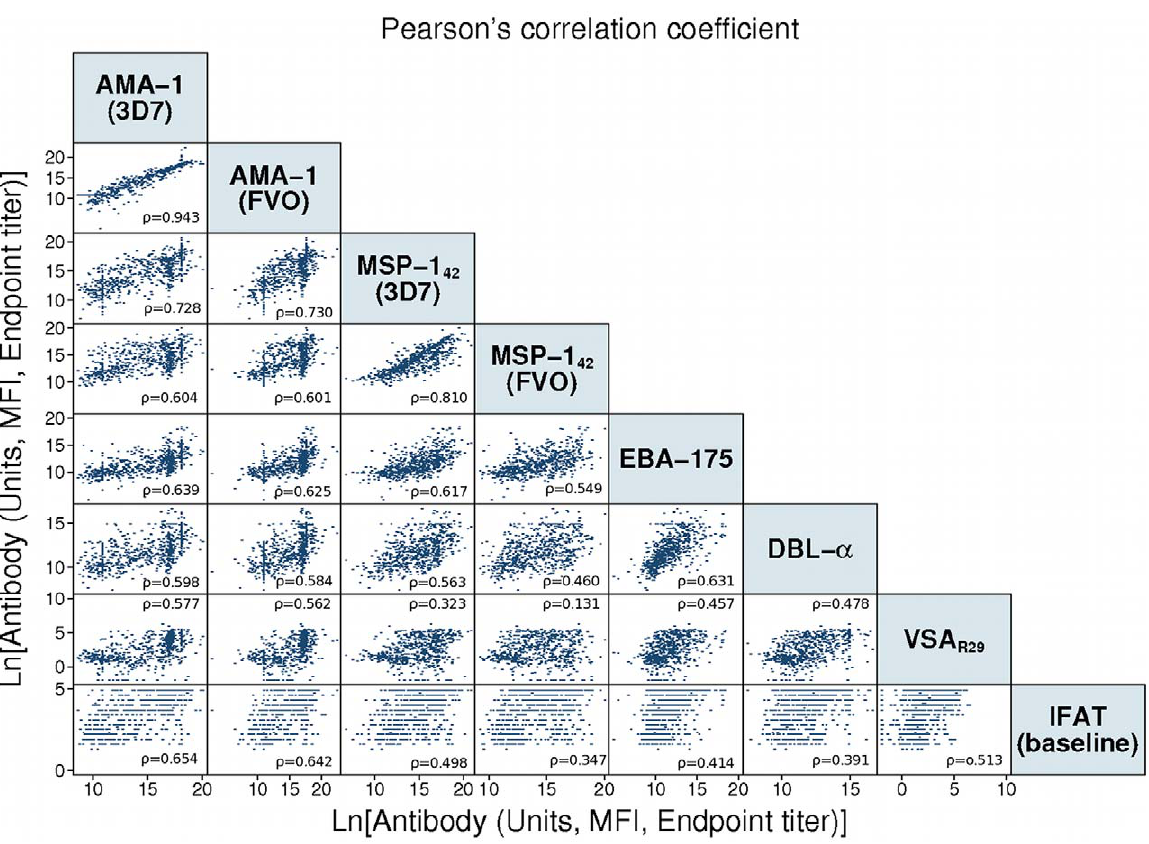
Figure 3. Correlation of antibody responses to merozoite and VSA antigens within the individual. A matrix of log-transformed antibody units or mean fluorescence intensities (VSA R29 ) against the selected blood stage antigens shows correlation of antibody responses between antigens. Pearson’s correlation coefficient ( r ) is included in each antibody combination panel (p-value , 0.001 for all correlations).